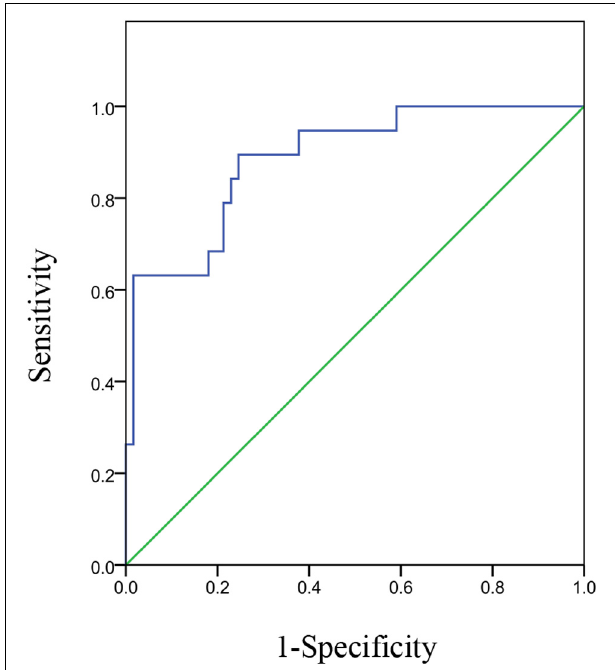
FIGURE 3 | Receiver-operating characteristic (ROC) curve of the predictive model as a predictor of acute mountain sickness (AMS) in young men as determined by logistic regression analysis. The area under the ROC curve for the model was